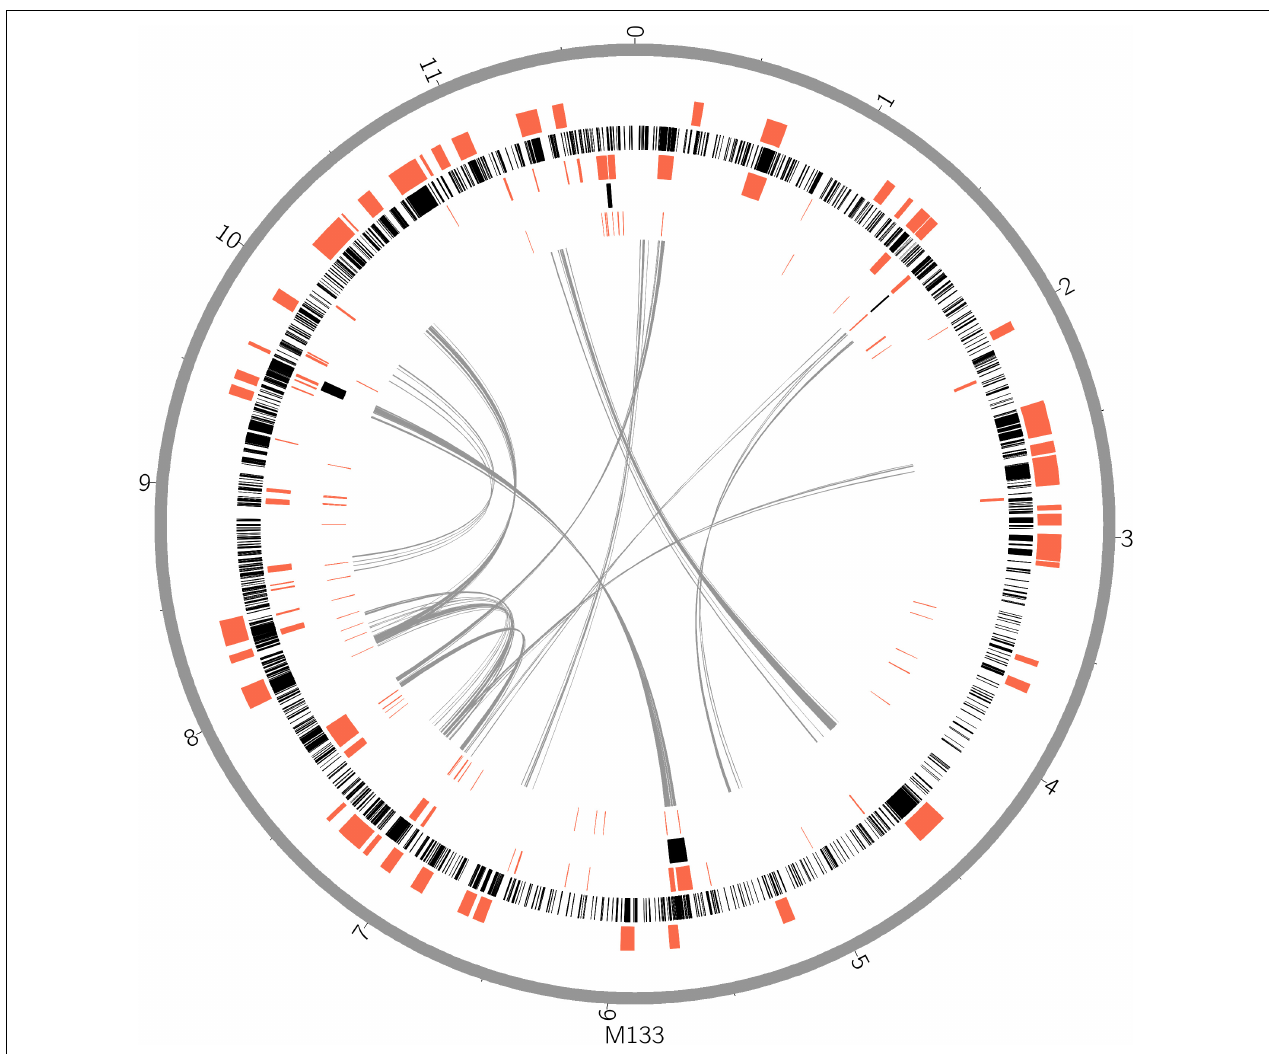
FIGURE 1 | Horizontal gene transfer and gene duplication shaped the large genome of strain M133 T . From outer circle to inner, genome scale (gray), biosynthetic gene clusters (red), coding gene duplications (black), genomic islands, insert sequences, intra genome collinearity were displayed. Genome size unit,